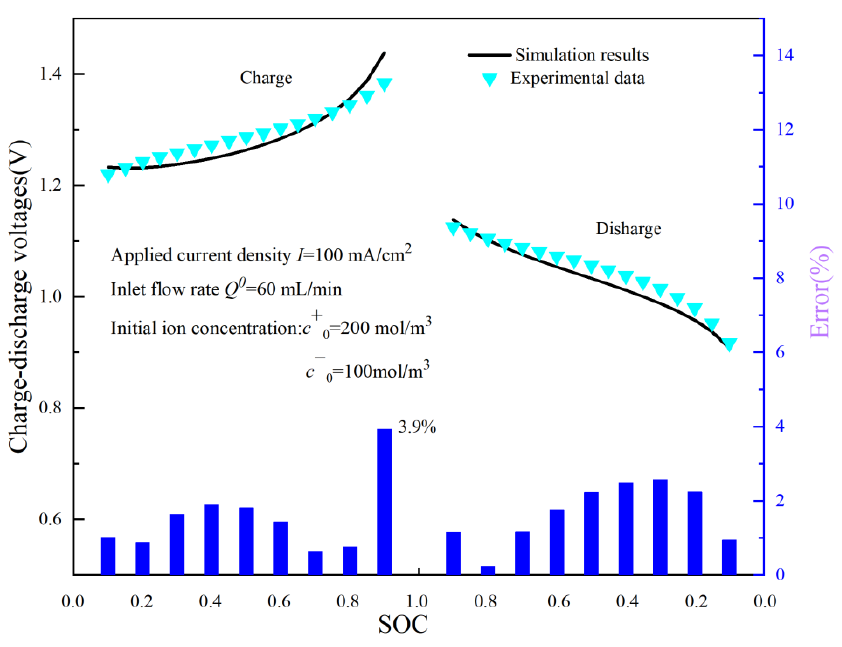
Figure 2. Comparisons between numerical and experimental data.